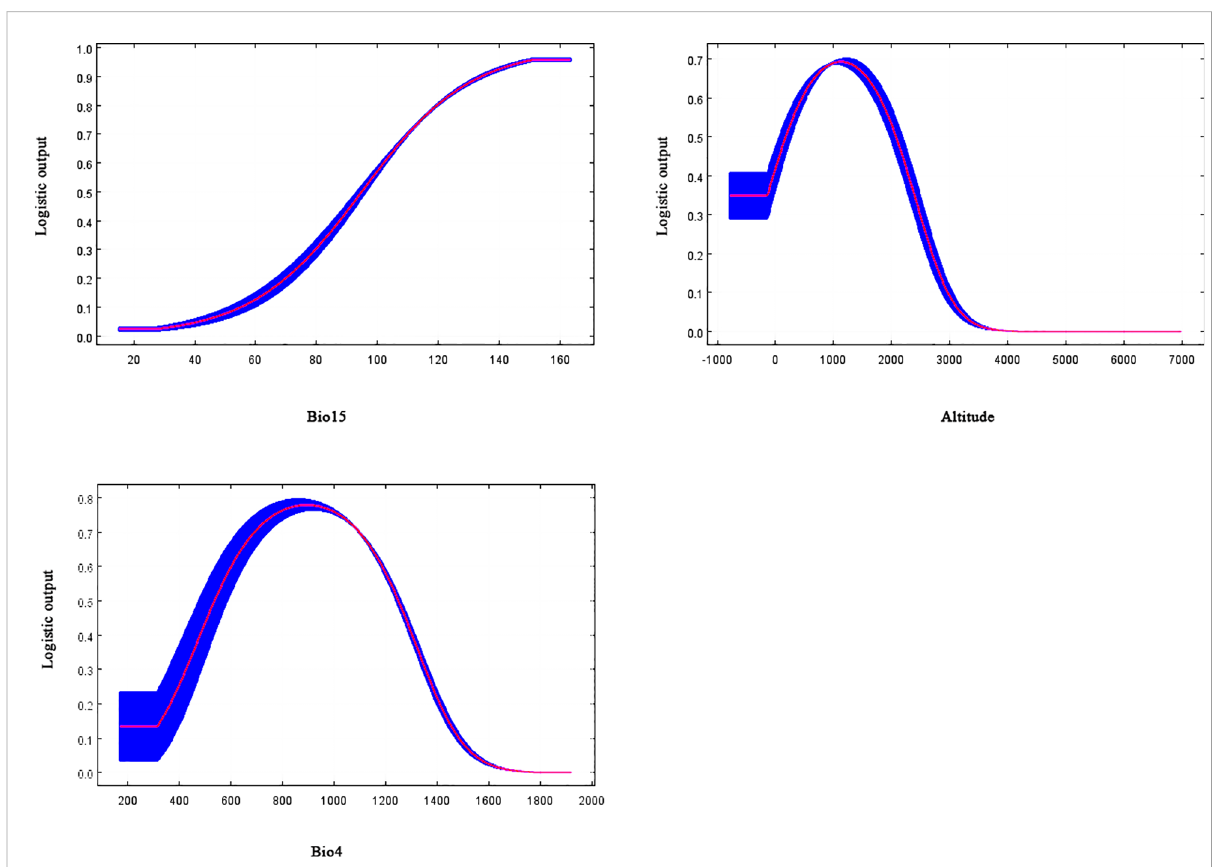
FIGURE 5 Response curve of naked oat existence probability to the main